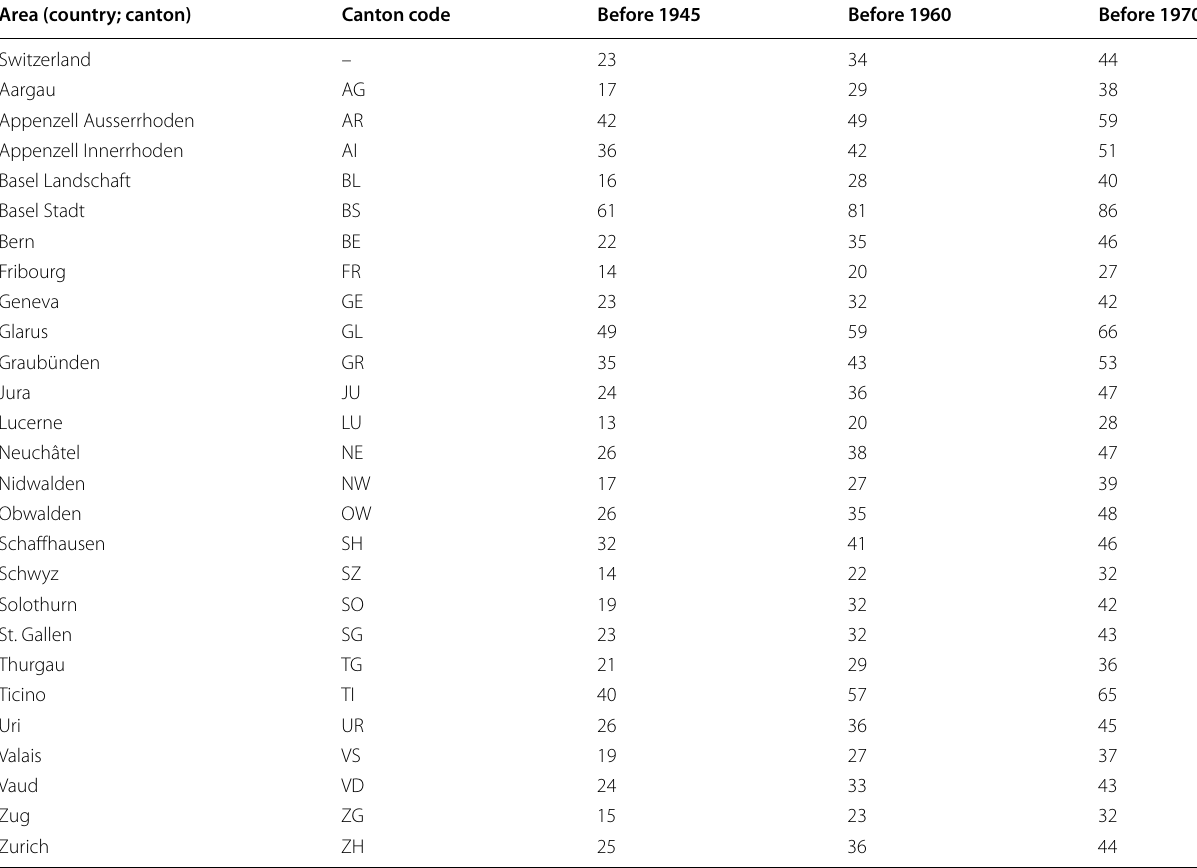
The respective shares are given in percent